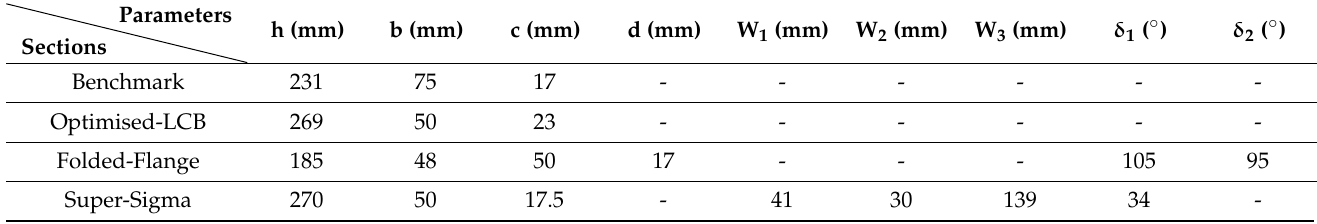
Table 5. Dimension details of selected